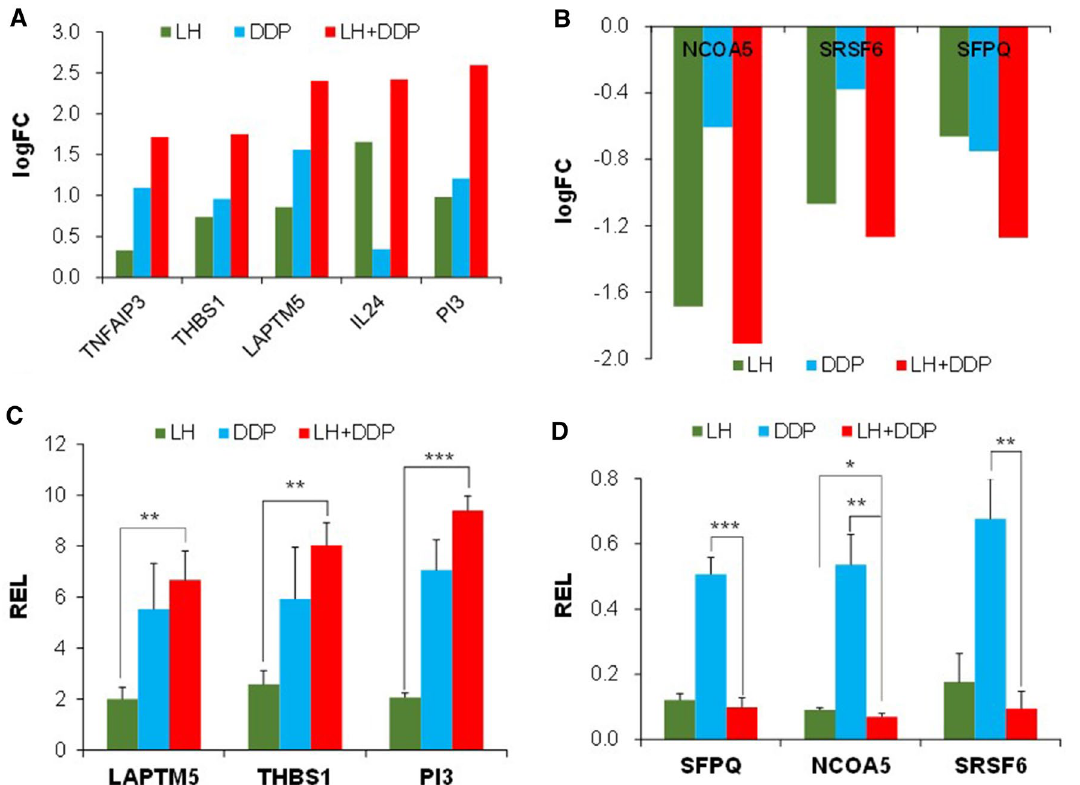
Fig. 5 Combination of levofloxacin and cisplatin regulates genes in direction supporting the enhancement of anticancer efficacy. A LogFC of the upregulated differential genes. B LogFC of the downregulated differential genes. C REL of the upregulated differential genes. D REL of the downregulated differential genes. REL = 1 in PBS control group. Data are expressed as mean ± SD from 3 biological replicates in RT–qPCR. Compared with PBS control group: * p < 0.05, ** p < 0.01, *** p <